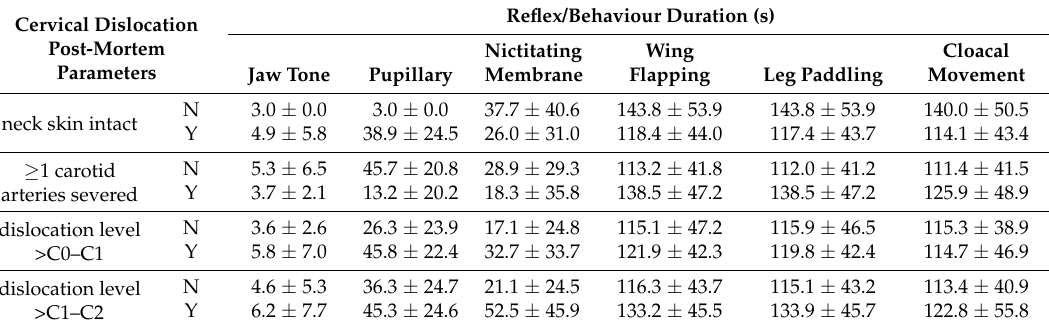
Table 3. Mean ( ± SD) duration (s) of reflexes and behaviours post cervical dislocation (manual + mechanically-assisted) killing method application in relation to achieved (Y/N) post-mortem parameters.